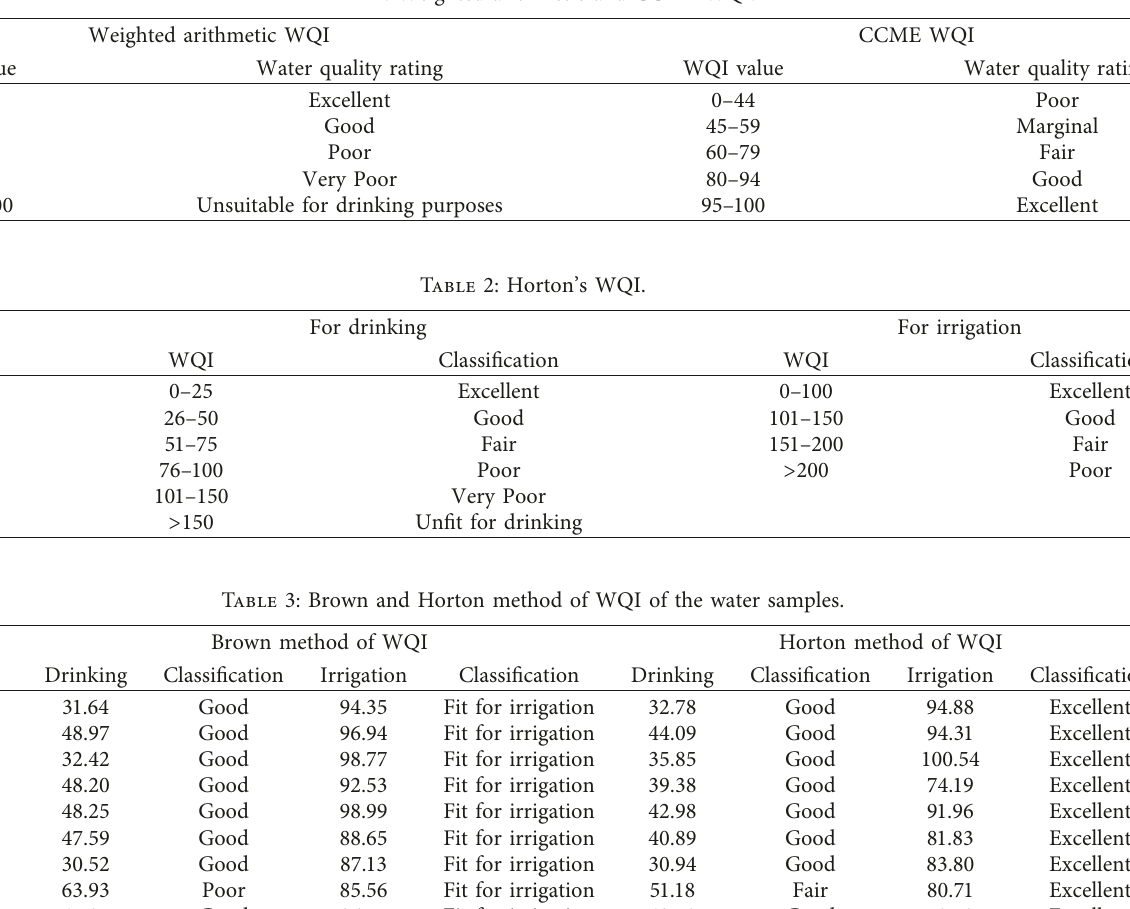
Table 1: Weighted arithmetic and CCME WQI.